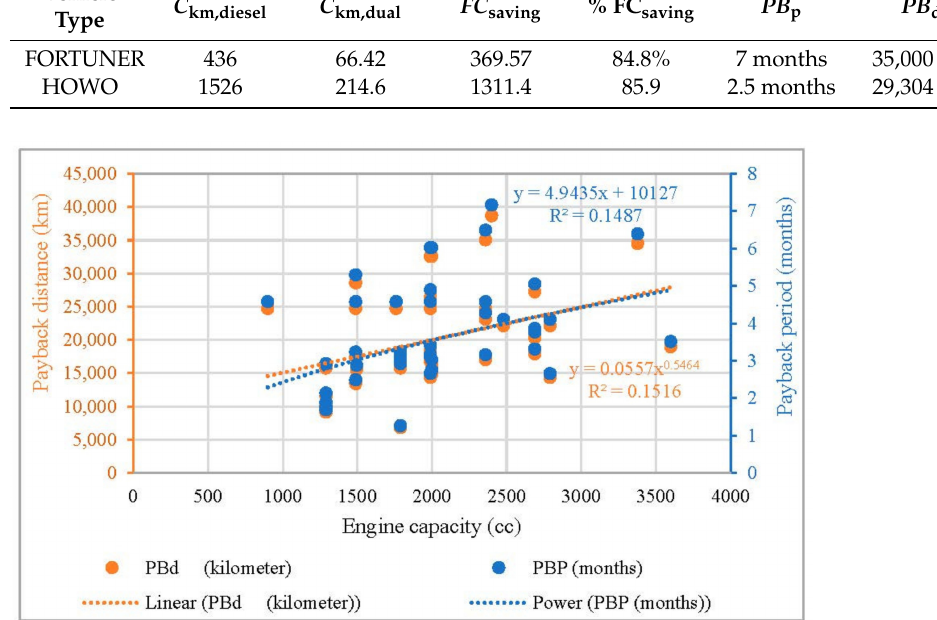
Figure 6. The comparison of payback distance and payback period for gasoline vehicles with different engine